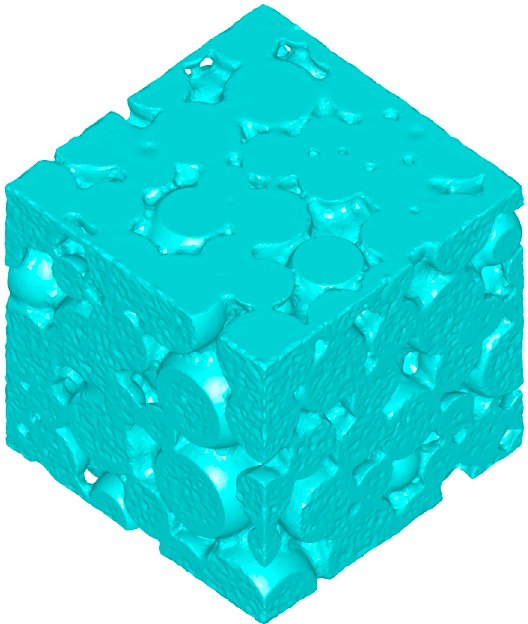
Figure 1. The reconstructed geometry using the proposed workflow.